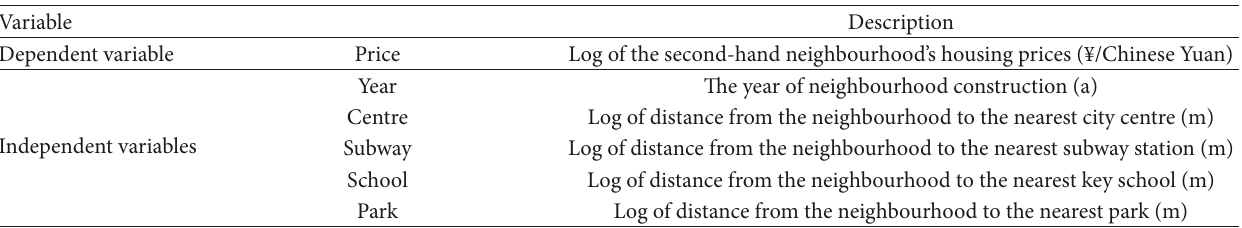
Table 3: Descriptions of